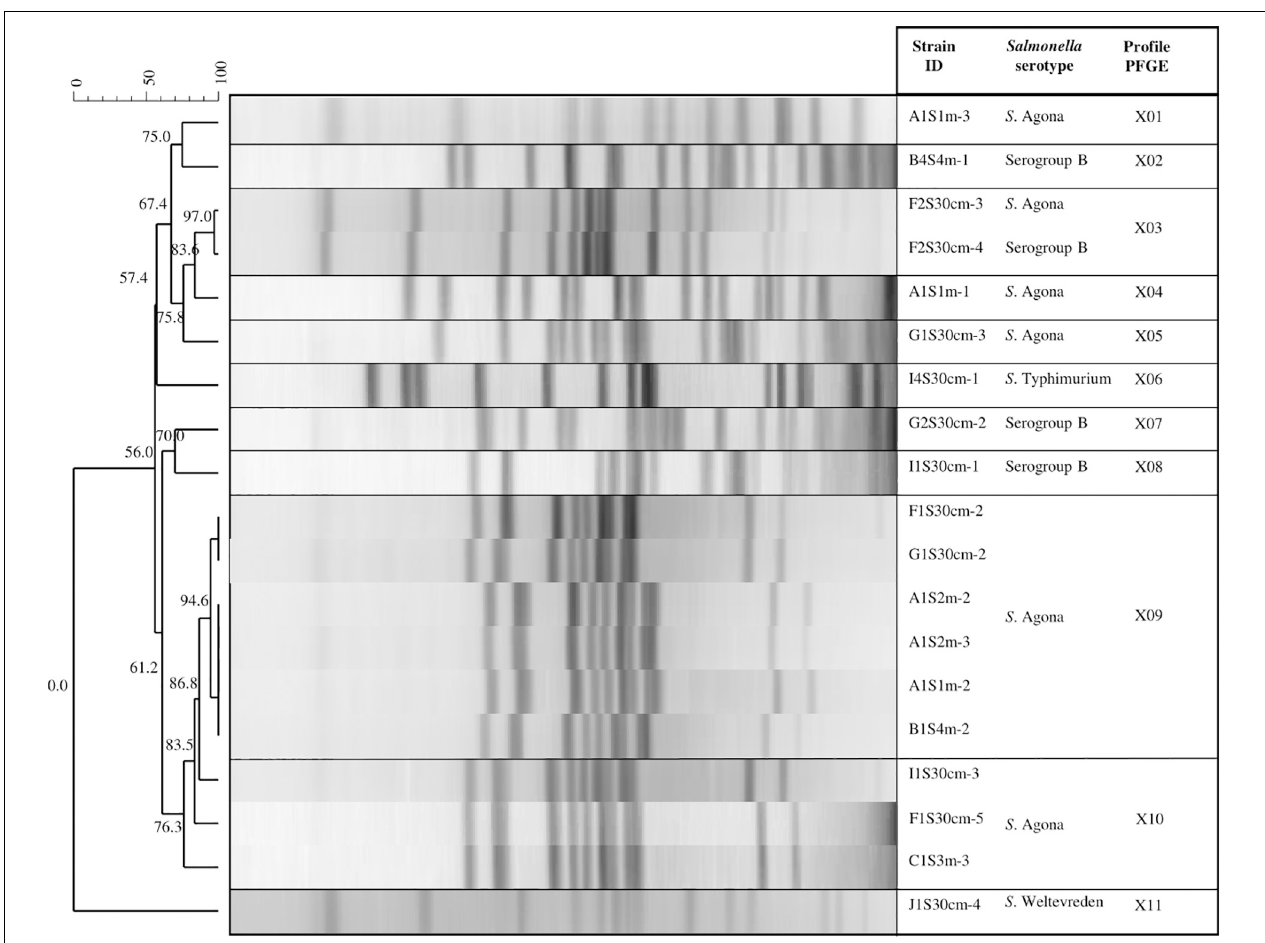
FIGURE 4 | Pulsed field gel electrophoresis (PFGE) Xba I dendrogram showing the relationship between Salmonella strains. The code for the isolated Salmonella strains: The first letter corresponds to the sampling site (A, B, C, F, G, I, or J); the second and third letter indicate the sampling month (1S, 2S, or 4S); the fourth specifies the depth (30 cm, 1, 2, 3, and 4 m); and the dash and number represent an isolated colony within a